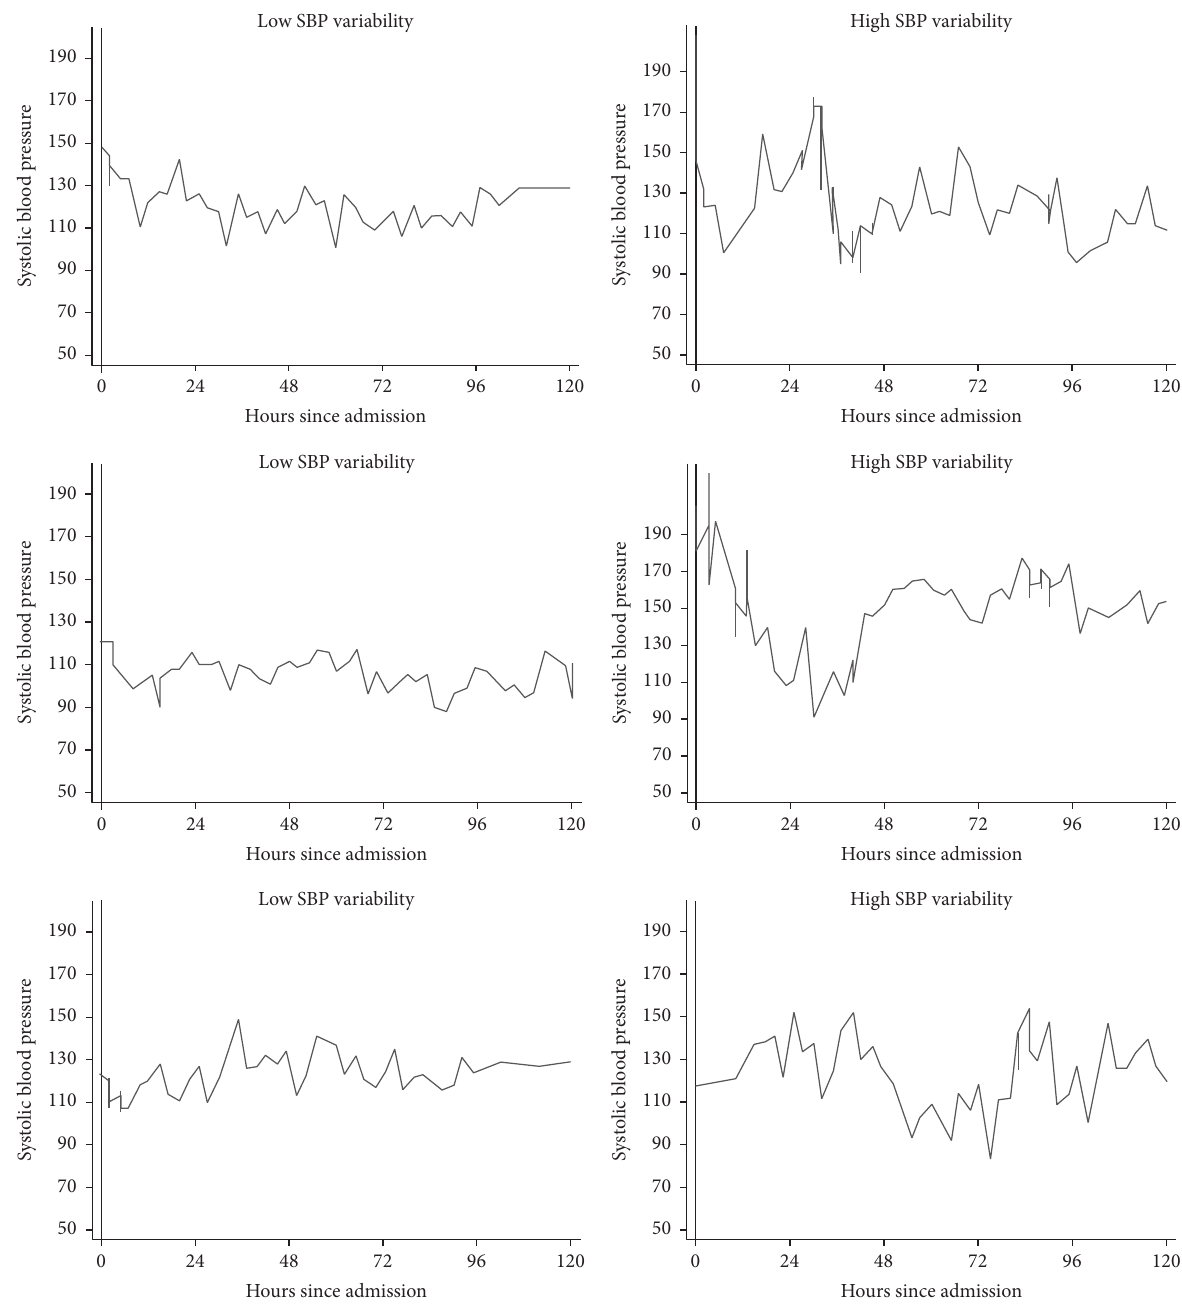
Figure 1: Systolic blood pressure plotted against hours since hospital admission in 6 representative patients, showing high and low variability.